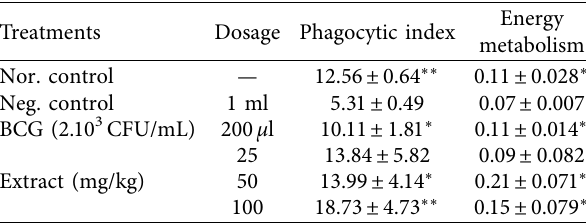
Neg. control: prednisolone-treated animal and receiving the vehicle (saline solution) and Nor. control: normal control. Asterisks ( ∗ p < 0 . 05, ∗∗ p < 0 . 01, and ∗∗∗ p < 0 . 001) indicate the significant difference as compared to negative control.